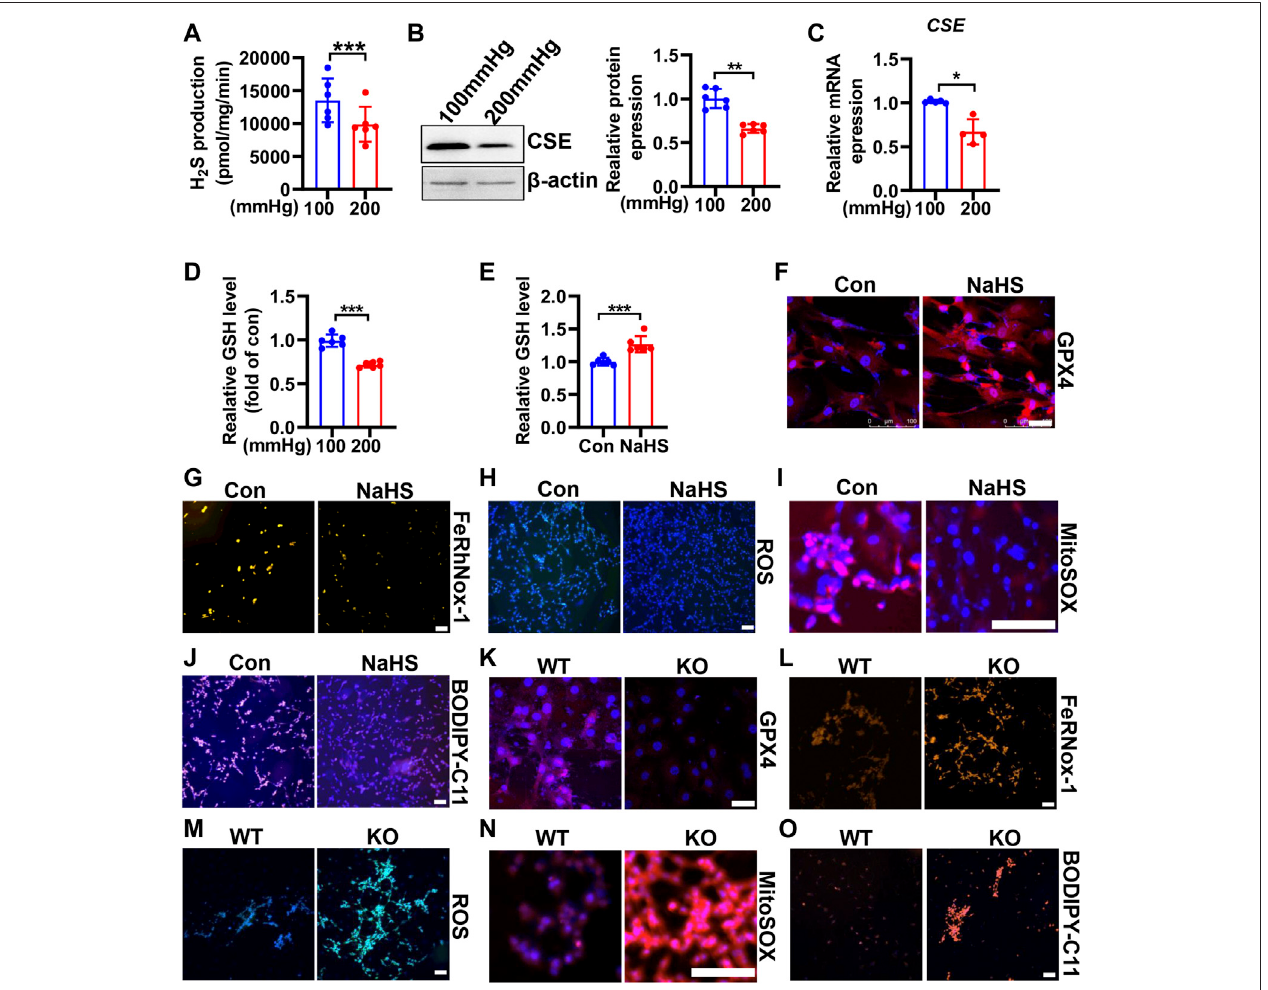
FIGURE 5 | CSE/H 2 S attenuates HHP-induced ferroptosis in VSMCs. H 2 S production was measured by the modi fi ed methylene blue method under 100 or 200 mmHg (A) . Western blot assay analysis of the CSE expression under hydrostatic pressure; the left panel is the representative image, and the right panel is the statistical graph (B) . CSE mRNA level under hydrostatic pressure (C) . GSH assay kit measured the GSH level in response to hydrostatic pressure (D) . After NaHS administration (0.1mM, 24 h) in the presence of 200 mmHg, the GSH content was measured (E) . Representative image of GPX4 staining after NaHS treatment under HHP conditions (F) . Effect of NaHS on Fe 2+ (G) , ROS (H) , mitochondrial ROS (I) , and lipid oxidation (J) under 200 mmHg by immuno fl uorescent staining. In isolatedprimarymouseVSMCs,theeffectofdeletionofCSEontheGPX4expression (K) ,ironlevel (L) ,ROSproduction (M) ,mitochondrialROSproduction (N) ,andlipid peroxidation (O) under HHP conditions by immuno fl uorescent staining. All scale bar = 50 μ M * p < 0.05, ** p < 0.01, *** p < 0.001.